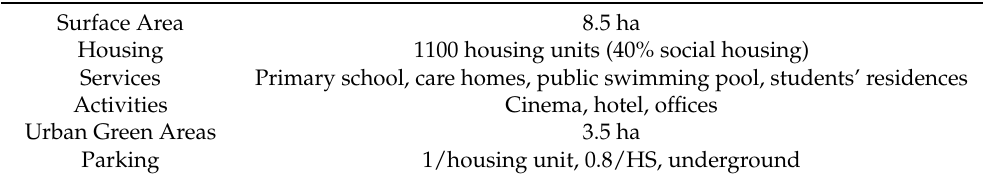
Table 8. The projects. Source: Authors’ elaboration (2022) based on data from the site http://www. ecoquartiers.logement.gouv.fr (accessed on 19 June 2022).